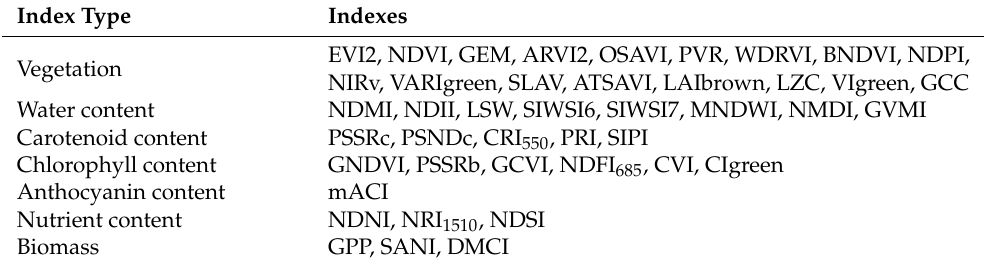
Table 1. Spectral indexes.